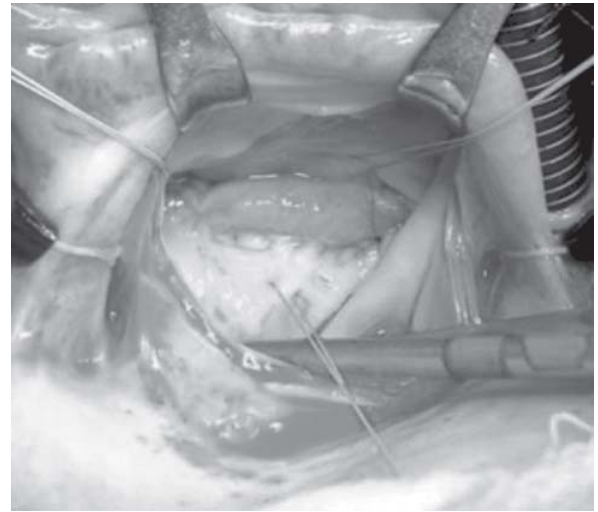
Fig. 3 – Sutura do enxerto, no anel e na borda do folheto